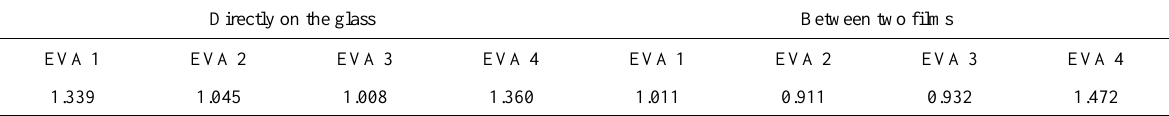
Table 5: Average shear modulus of the samples with liquid paint applied with a brush (MPa) Directly on the glass Between two